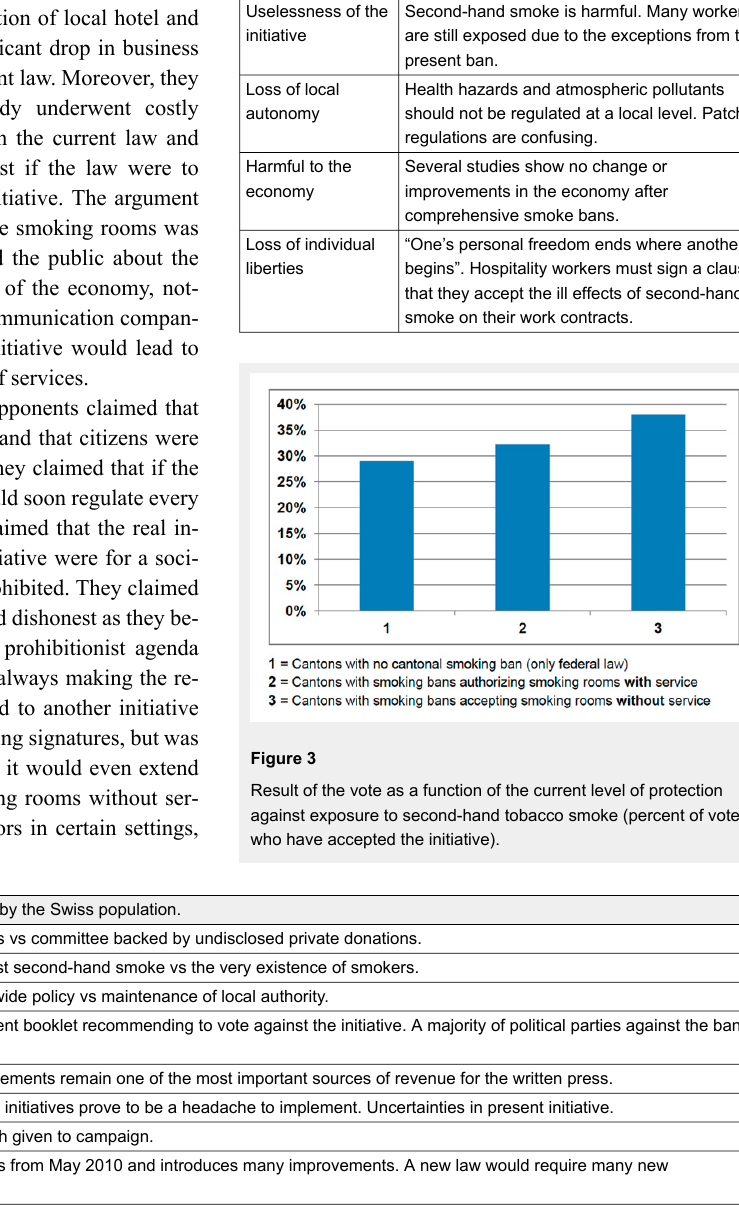
Table 1: Arguments against the ban by the opposition committee and counter arguments. Uselessness of the initiative